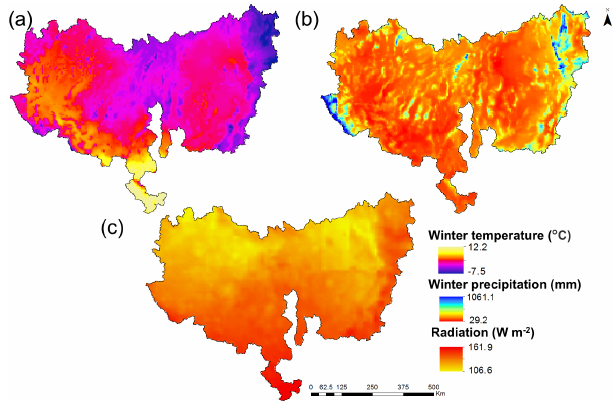
Figure A2. (a) Average winter temperature, (b) average winter pre- cipitation, and (c) average winter radiation across water years 2001– 2015 in the Great Basin.